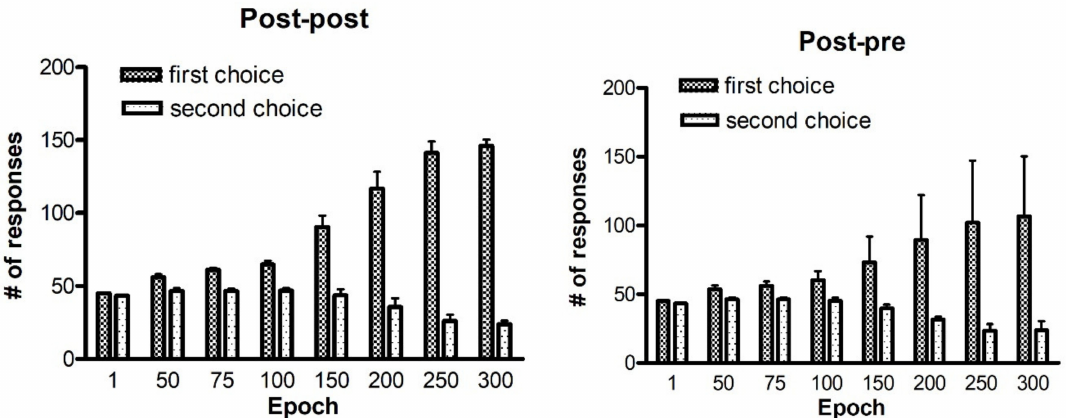
Figure 8. This figure shows the capacity to perform the task correctly in the case of a four-action task (i.e., to select the more correct response, that is the first choice, and the second more correct response, second choice) as a function of the duration of the previous training. Each test consists of 300 trials, in which the stimulus associated with each action is given 50 times. The bars represent mean values and standard deviation on 10 independent learning procedures. The left panel refers to the post-post rule, the right panel to the post-pre rule.